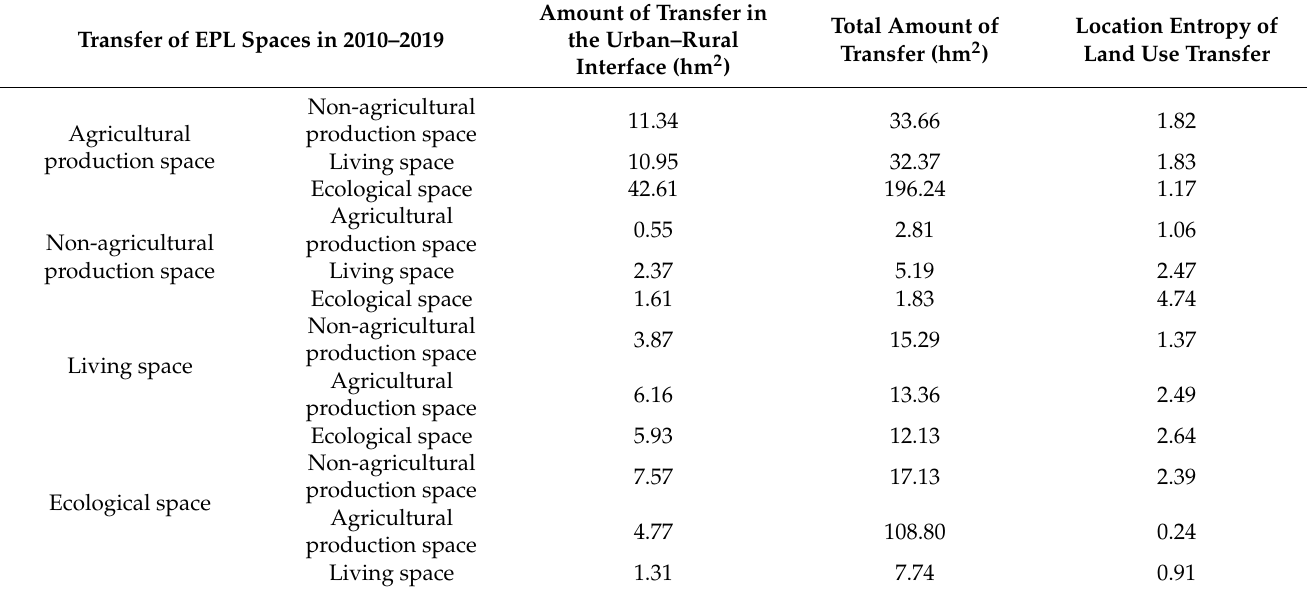
Table 11. Spatial transfer of EPL spaces in the urban–rural interface area from 2010 to